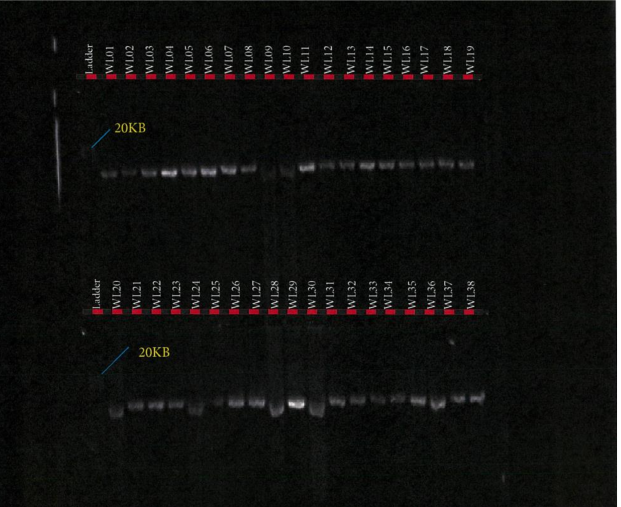
Figure 2. FASN fragment 1 PCR product in Tattykeel Australian White (WL), Poll Dorset (PD), and Texel (TX) lambs.